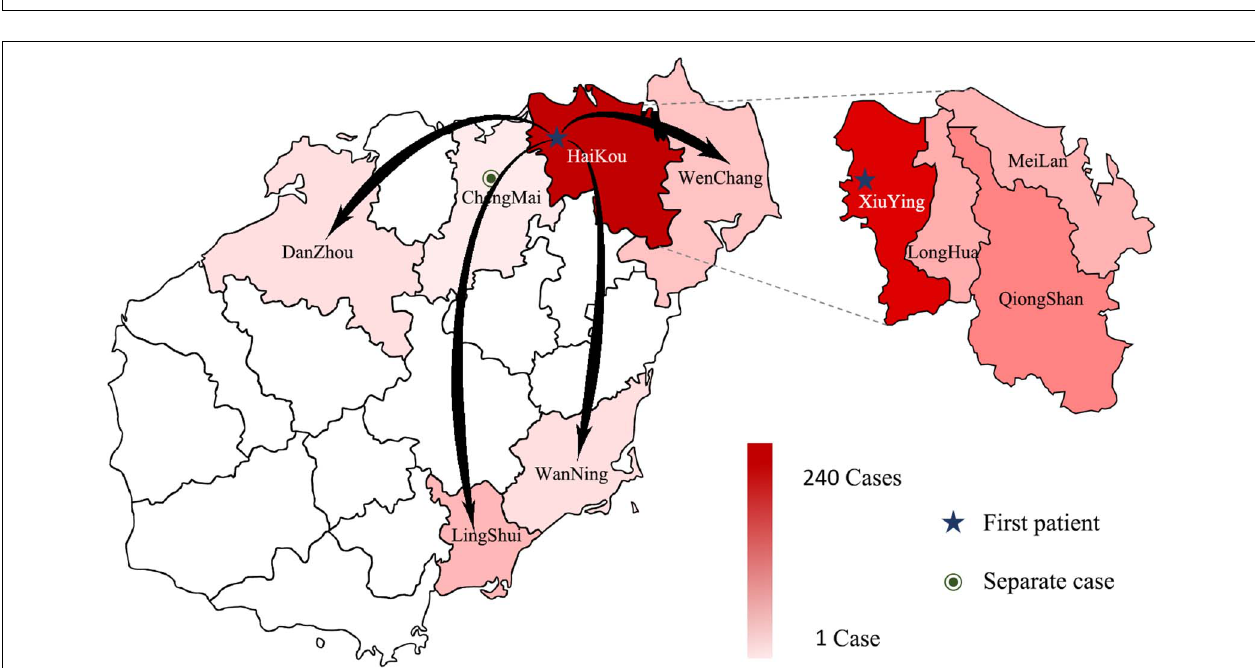
FIGURE 2 | The distribution of DENV in Hainan in 2019. The intensity of the colors in the figure indicates the number of dengue cases; the darker the color is, the more dengue cases there were in the area, arrows indicate the possible direction of propagation, dotted lines show the four Districts of Haikou city.